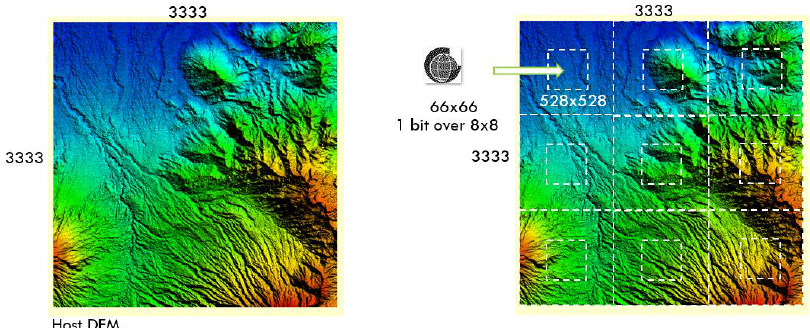
Figure 2. DCT Watermark Insert Scheme.